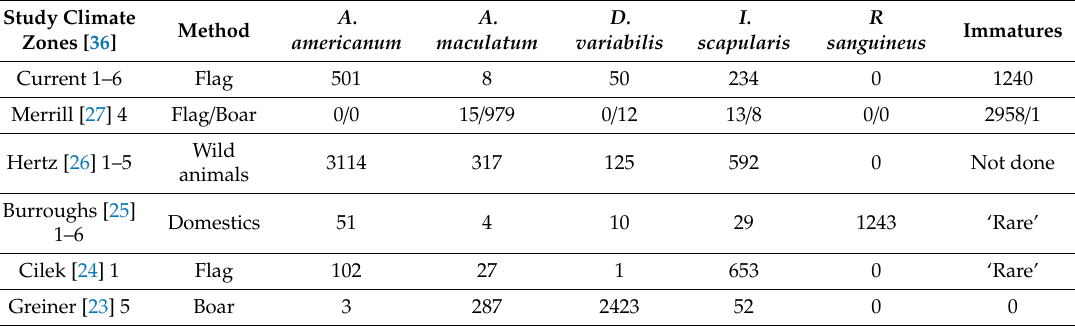
Table 1. Sample sizes from current survey and other, recent studies in Florida using di ff erent collecting methods. Numbers of adult and nymphal ticks are shown. Nymphs were primarily reported as A. americanum